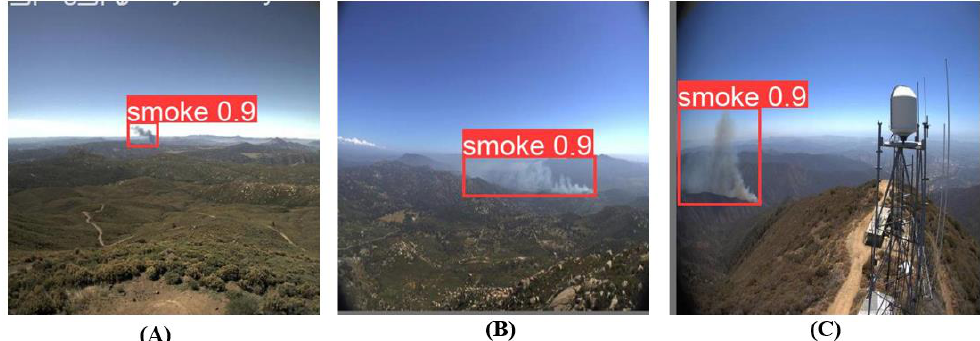
Figure 8. YOLOv5m detection areas results. ( A ) Far. ( B ) Medium. ( C ) Close.